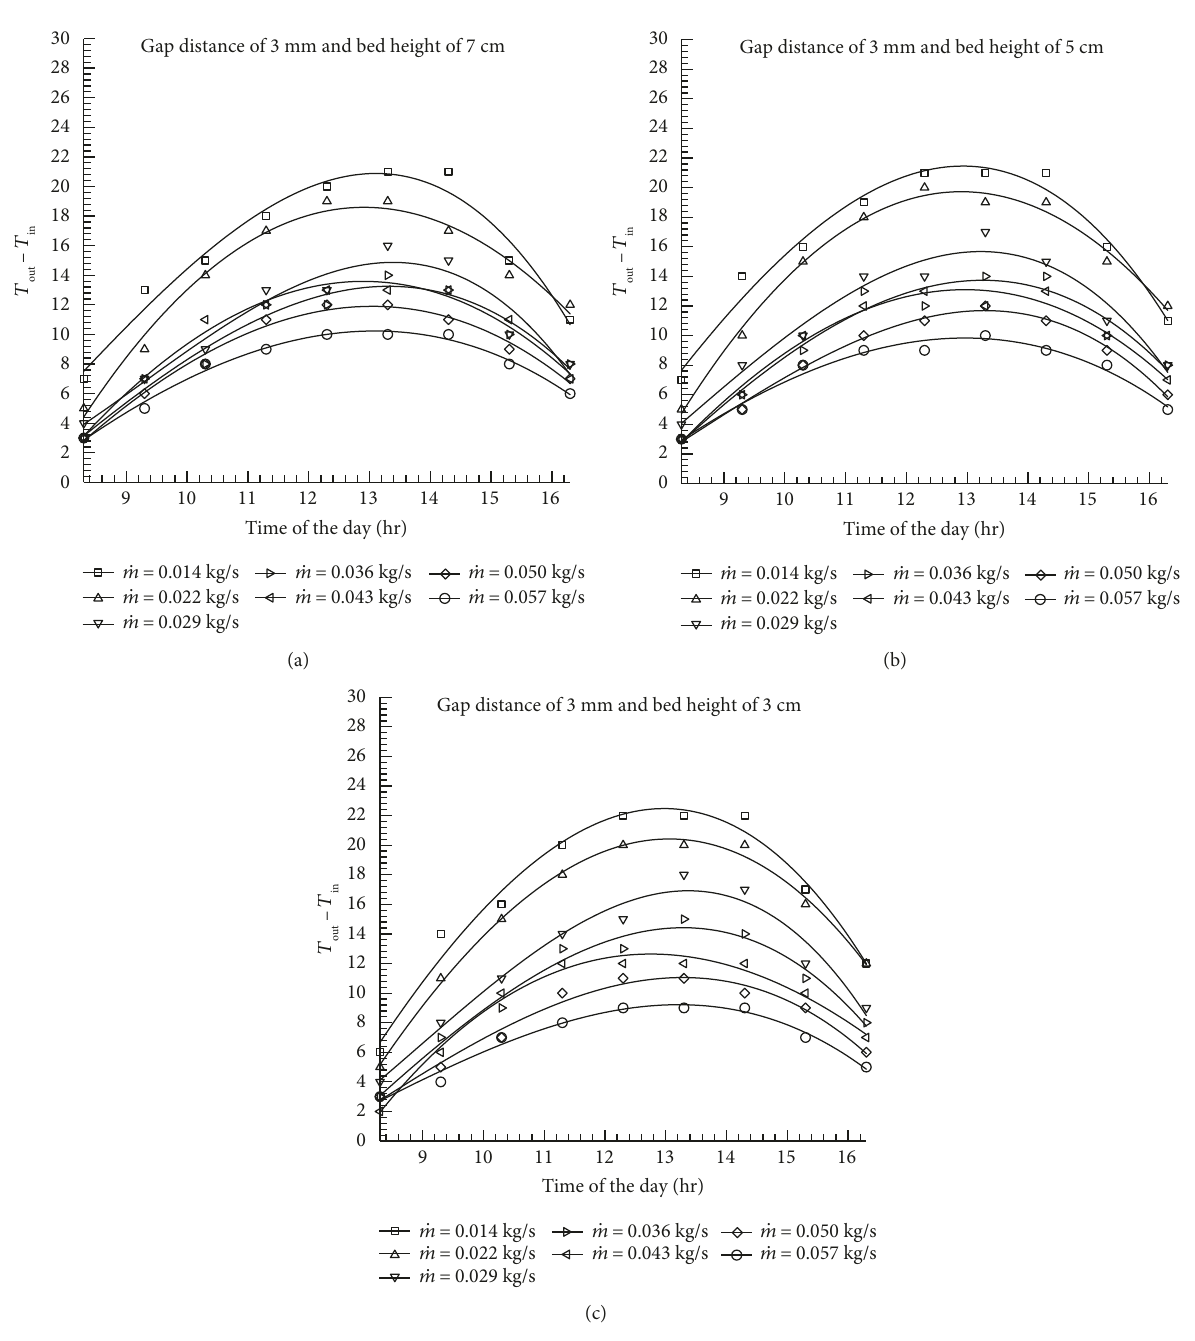
− T out in ) versus time at a gap distance of 3 mm for di